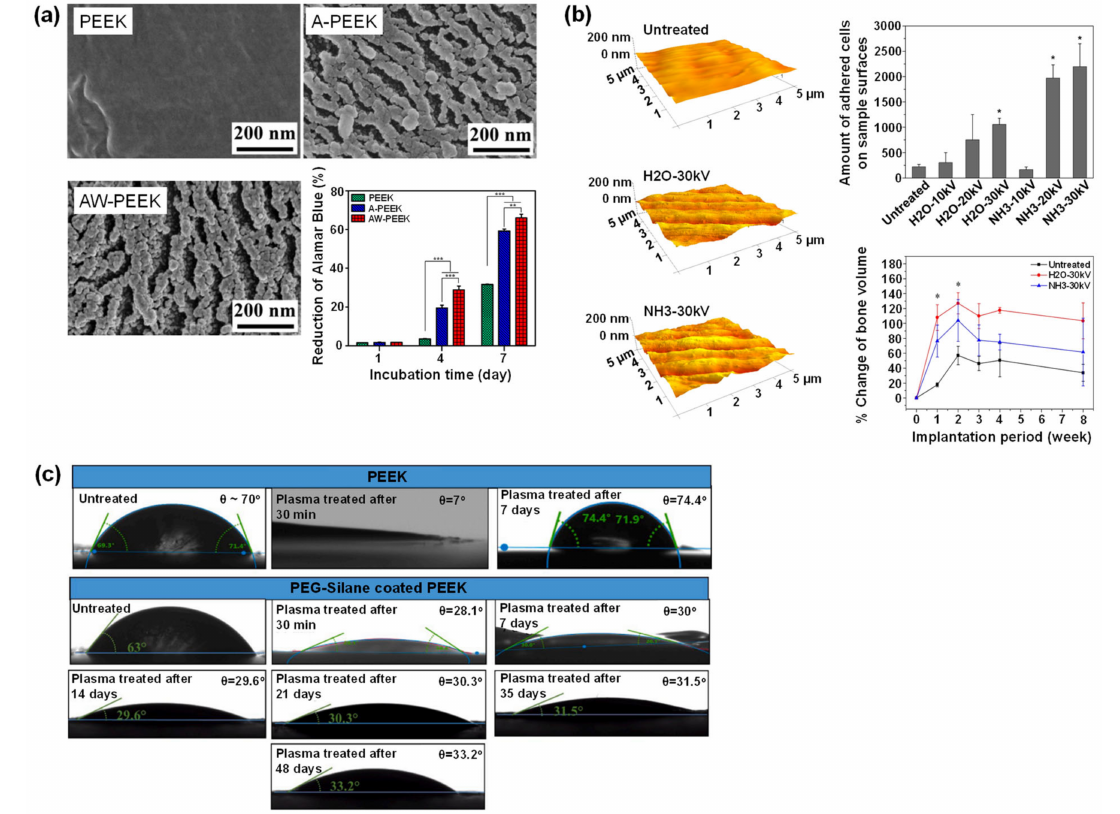
Figure 8. Plasma treatment of PEEK surface. ( a ) The work from Wang et al. showedsurface mor- phologies (characterized using field emission scanning electron microscopy) of untreated PEEK (PEEK), PEEK treated with argon plasma (A-PEEK), and PEEK treated with a mixture of water vapor and argon plasma (AW-PEEK). The Alamar Blue Assay was quantified against MC3T3-E1 cells (** p < 0.01, *** p < 0.001). A higher value of Alamar Blue Reduction indicates higher viability. ( b ) Zhao et al. showed AFM images and quantitative bioactivity analyses (MC3T3-E1 pre-osteoblast cell adhesion (* p < 0.05) and % change of bone volume of rats (* significantly higher bone formation after 1–2 weeks implantation)) of untreated PEEK, PEEK treated with H 2 O plasma and PEEK treated with NH 3 plasma. ( c ) Sundriyal et al. compared the time-dependent water contact angle for plasma- treated PEEK and plasma/PEG silane-treated PEEK. All figures were reprinted with permission from the literature